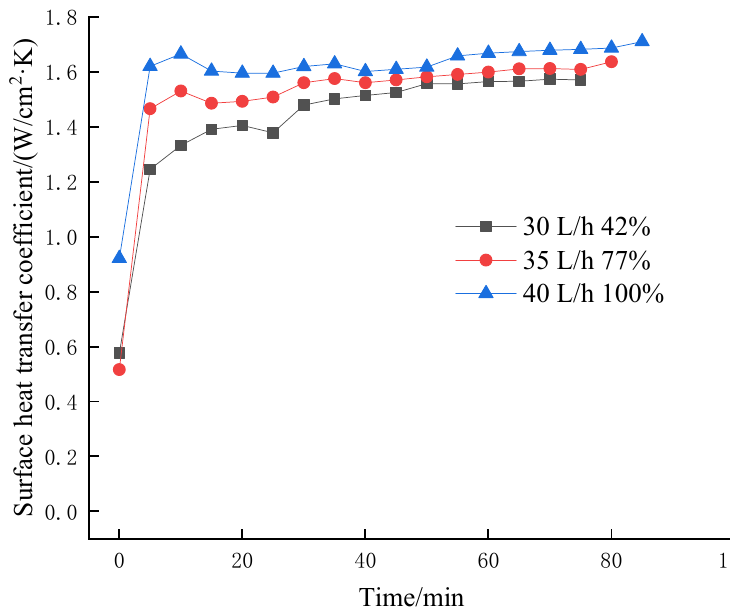
Figure 11. The influence of coverage rate of changing flow rate at 200 W/cm 2 on transient surface heat transfer coefficient.